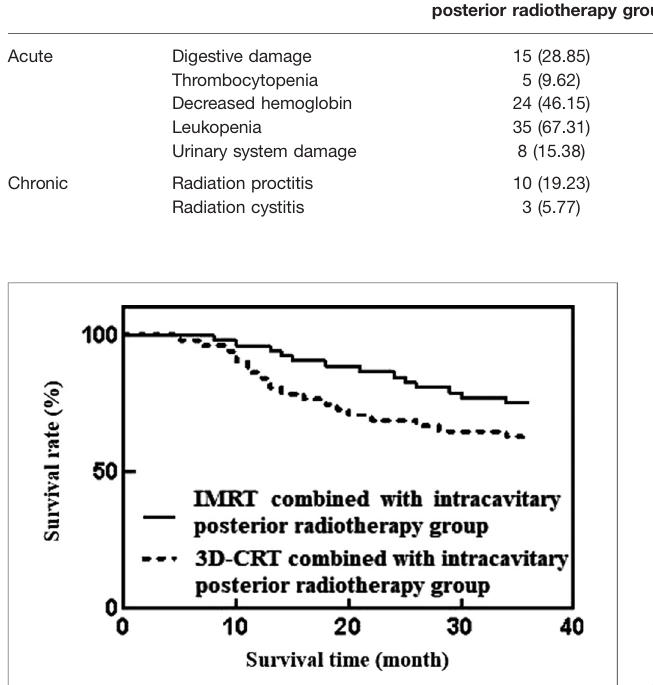
TABLE 2 | Comparison of the occurrence of adverse reactions of the two groups of patients ( n , %). Classi fi cation